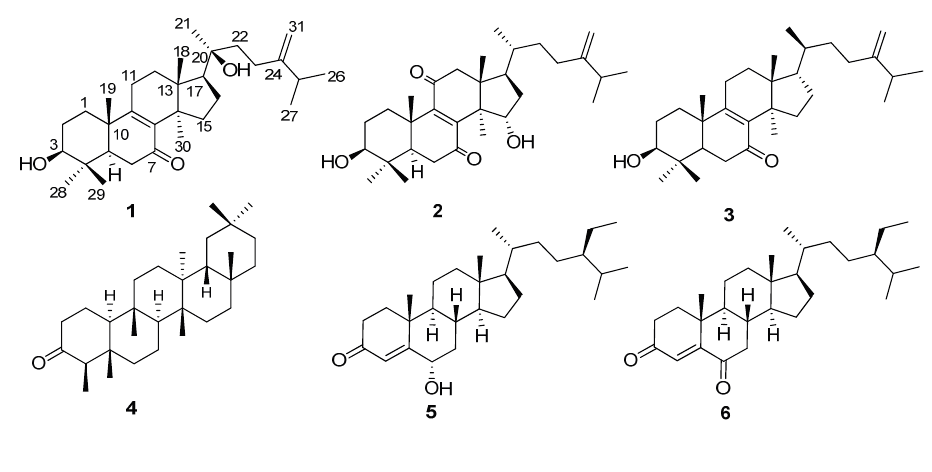
Figure 1. Structures of compounds 1 – 6